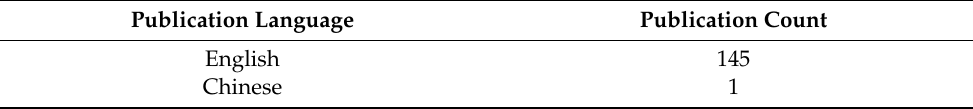
Table 3. Languages used for publishing on IOT in crop disease detection.